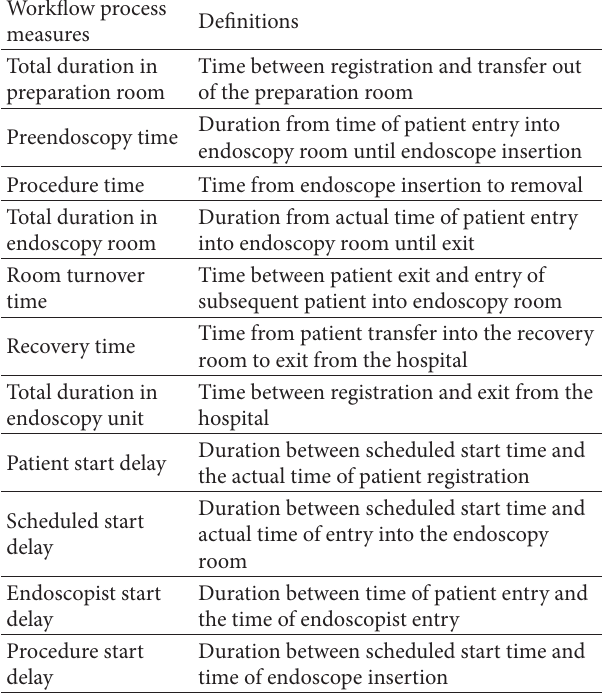
Table 1: Definitions of endoscopy workflow process